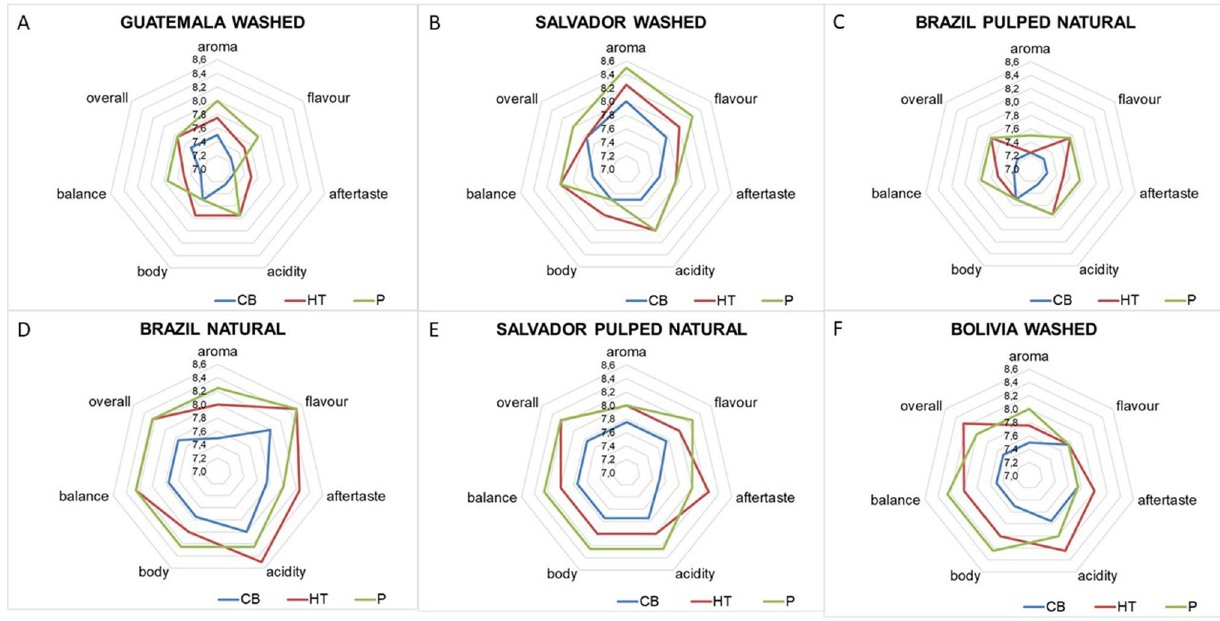
Figure 2. Sensory profiles of coffee samples: ( A ) Guatemala washed, ( B ) El Salvador washed, ( C ) Brazil pulped natural, ( D ) Brazil natural, ( E ) El Salvador pulped natural, ( F ) Bolivia washed. Mean values n =